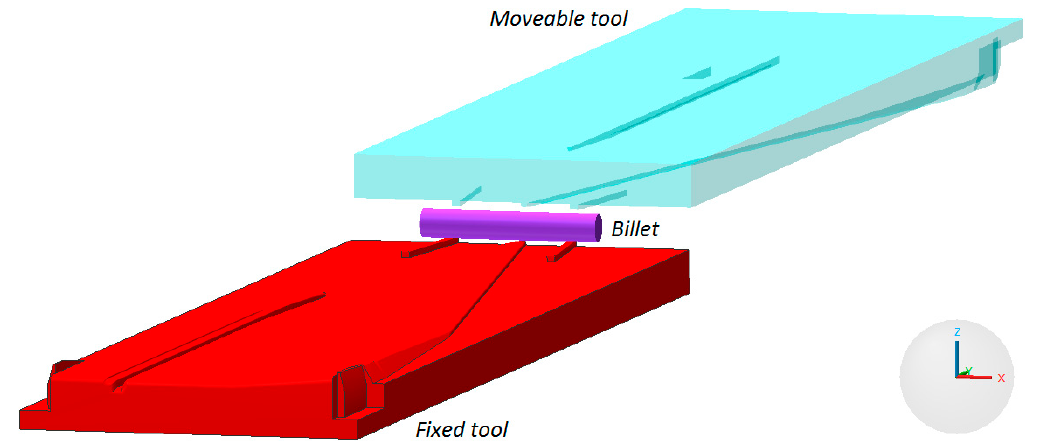
Figure 15. Geometrical model of the CWR process of the harrow tooth preform, realized from the billet with 22 mm diameter.